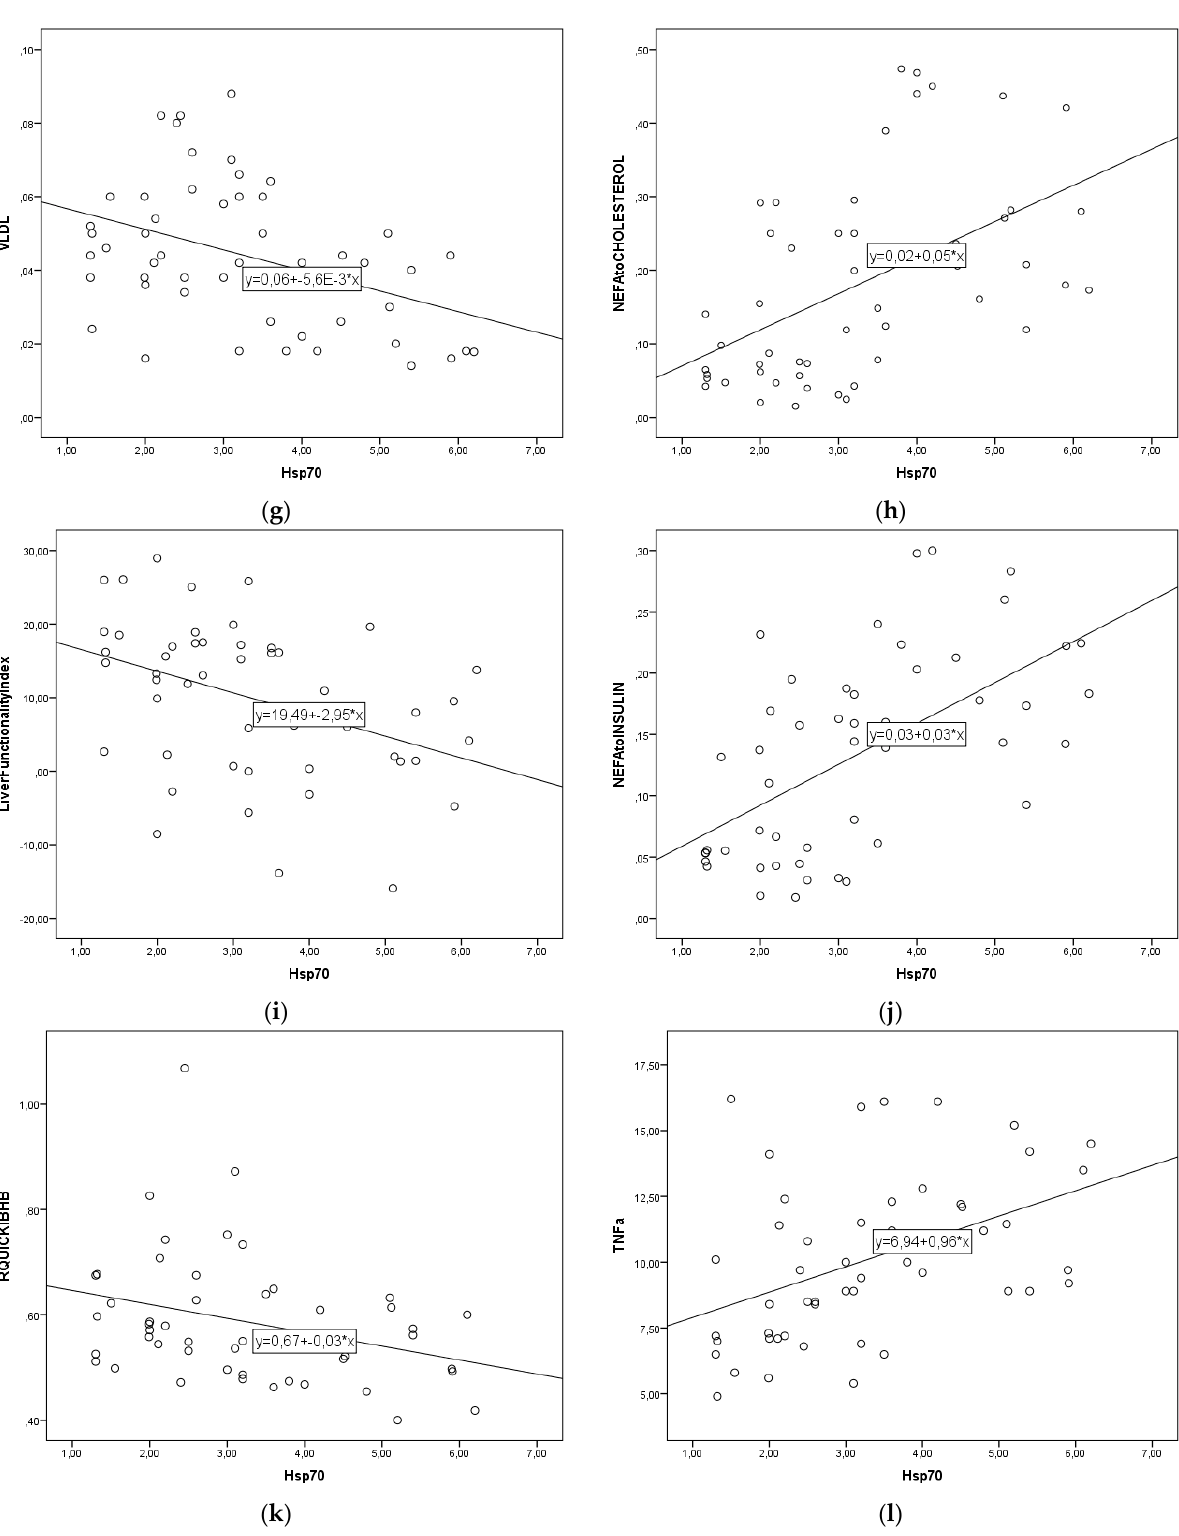
Figure 1. ( a – l ) . Linear regression lines between eHsp70 and cholesterol ( a ), triglycerides ( b ), NEFA ( c ), BHB ( d ), HDL ( e ), LDL ( f ), VLDL ( g ), NEFA to cholesterol ratio ( h ), Liver functionality index ( i ), NEFA to insulin ratio ( j ), RQUICKIBHB ( k ), TNF- α ( l ) in cows during early lactation.